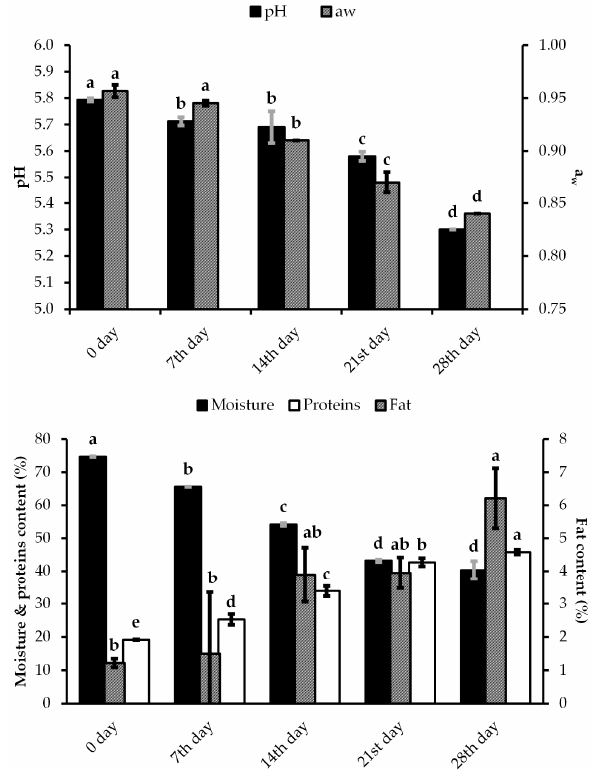
Figure 4. Physical–chemical parameters during ripening of “Pirot ‘ironed’ sausage” (mean ± st. deviation). Values within the same parameters during ripening followed by different letters are significantly different ( p < 0.05), according to Tukey’s HSD test. The colorimetric characteristics (L*—lightness; a*—redness; b*—yellowness) of the